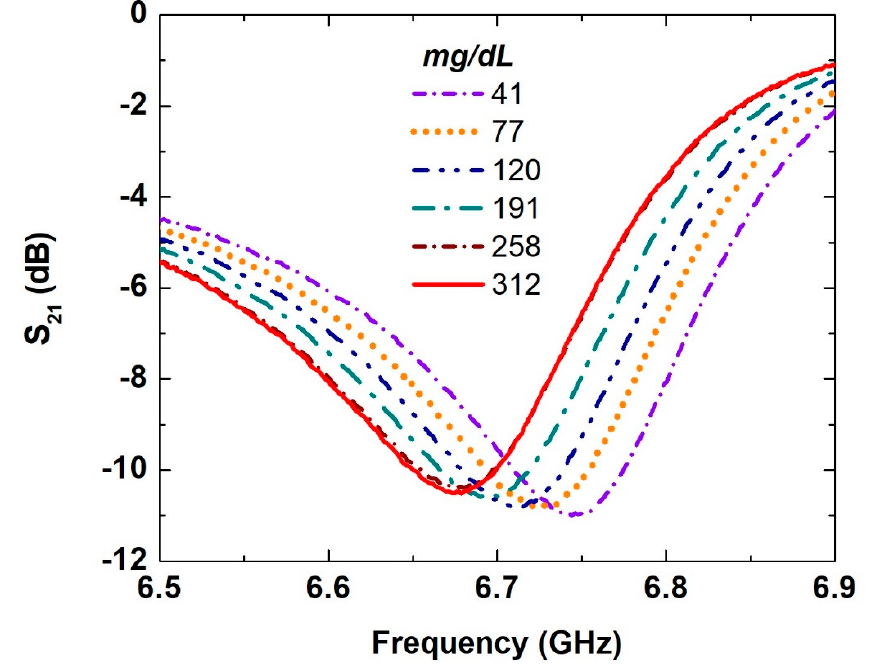
Figure 4. The measured transmission coefficient (S 21 ) of the SASR with different glucose solutions with concentrations of 41–312 mg/dL of 1 µL drop.